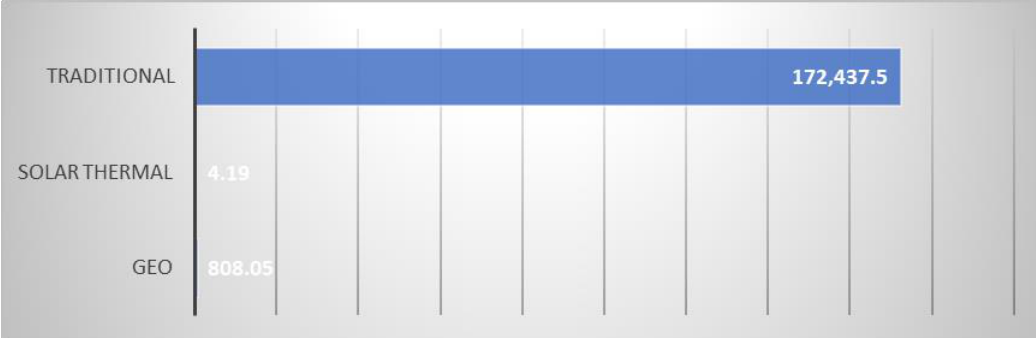
thermal cycles (Rankine and Brayton cycles) still lead the sector (2017).